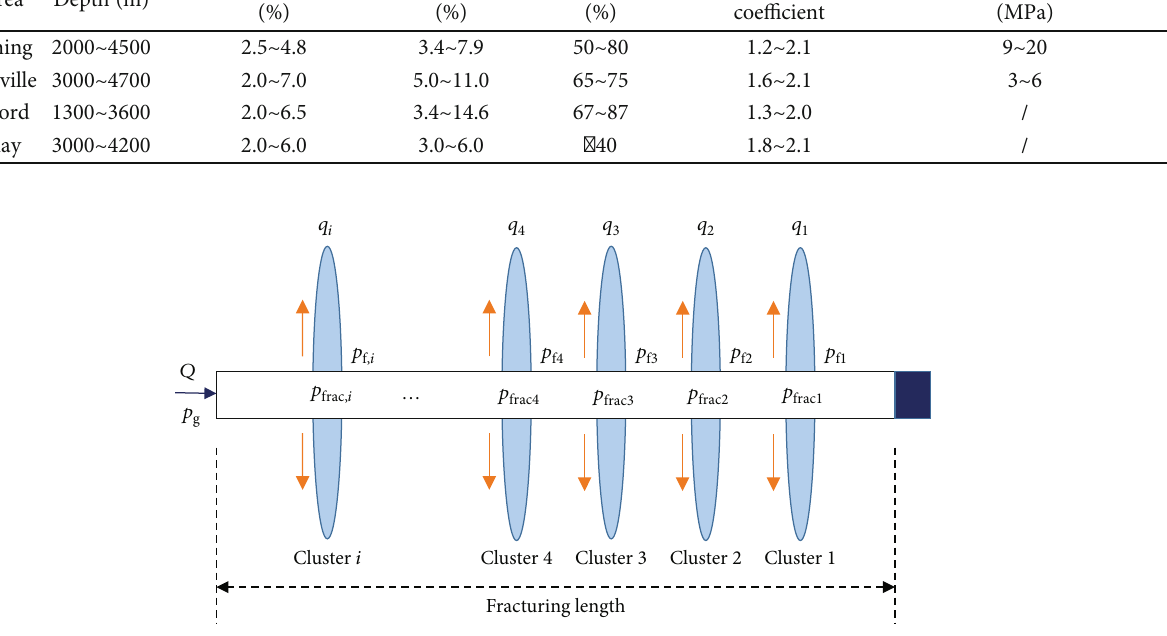
Table 1: Comparison of the main reservoir geological parameters in Changning and North America shale area. Shale area